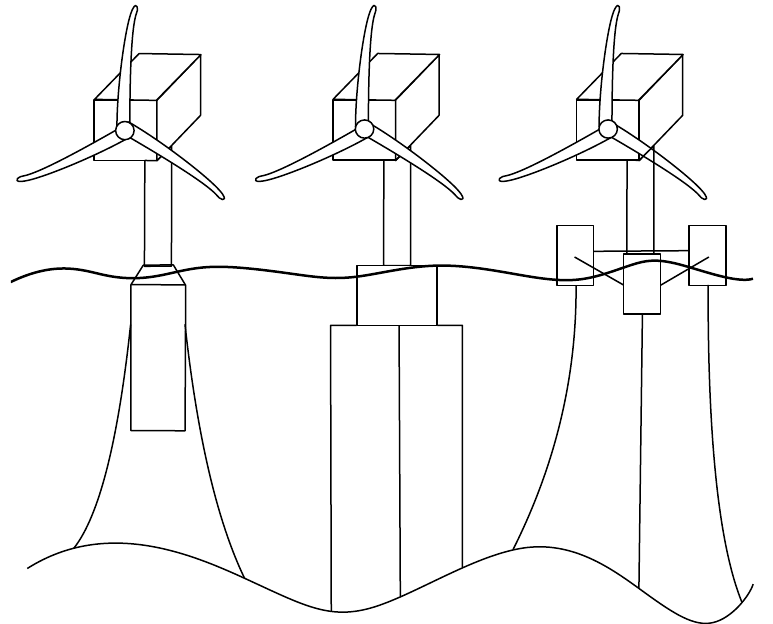
Figure 1. From left to right: Spar-buoy FOWT, TLP-based FOWT and semi-submerged